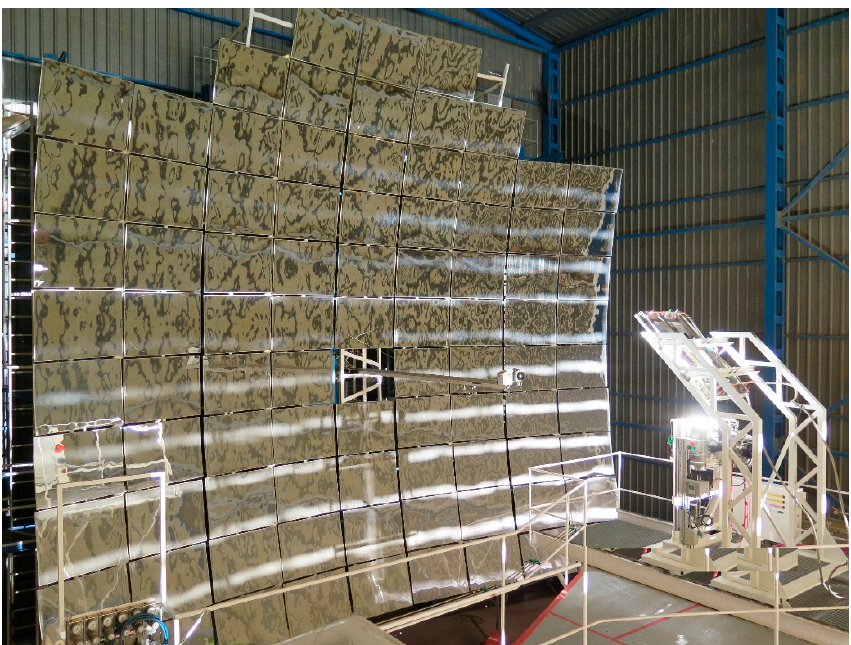
Figure 1. An indoor photo of the SF60 solar furnace, showing concentrator (left) and the 45°-tilted flat mirror (475 mm from the focal point) reflecting the concentrated solar radiation to the sample region below.